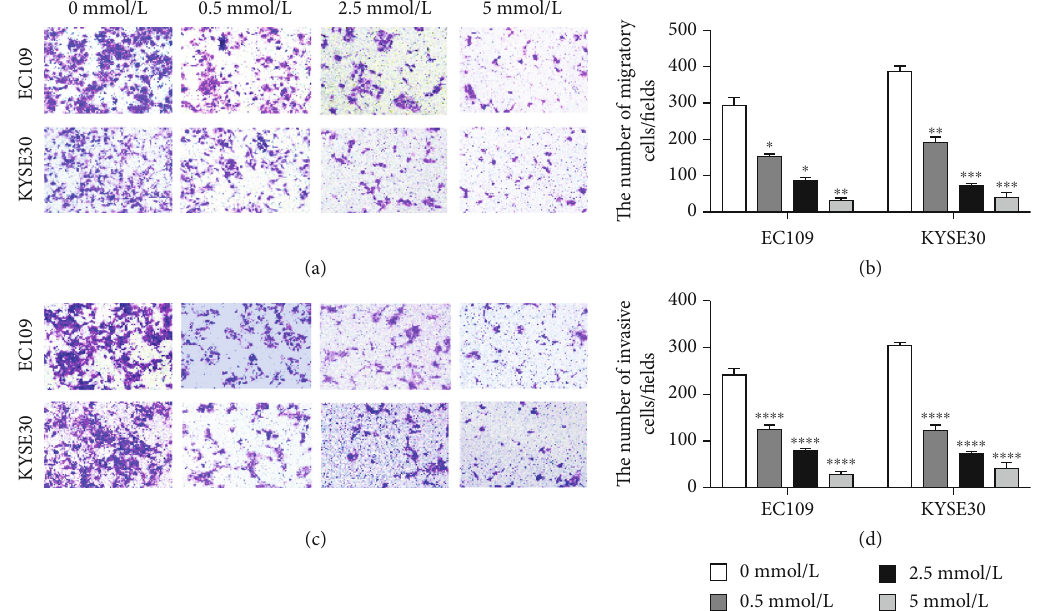
Figure 6: E ff ect of aspirin stimulation on migration and invasion of ESCC cells. (a, c) Transwell assay was performed to detect the e ff ect of aspirin on the (a) migration and (c) invasion abilities in EC109 and KYSE30 cell lines. (b, d) Treatment with aspirin inhibited the migratory and invasive abilities of EC109 and KYSE30 cells. ∗∗∗∗ P < 0 : 0001